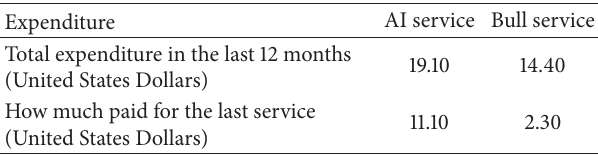
Table 2: Cost of breeding services previously